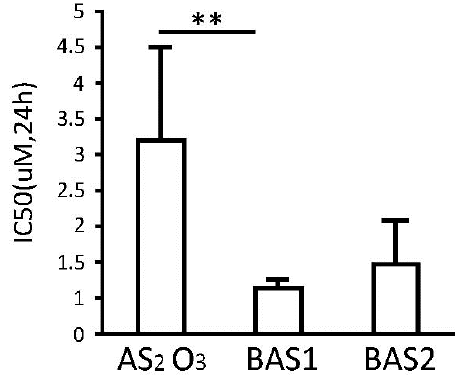
Figure 1. Effect of As 2 O 3 , biotin-As I (BAS1) and biotin-As II (BAS2) on NB4 cell growth. Each value represents the mean ˘ SD ( n = 6) of three independent experiments. ** p <